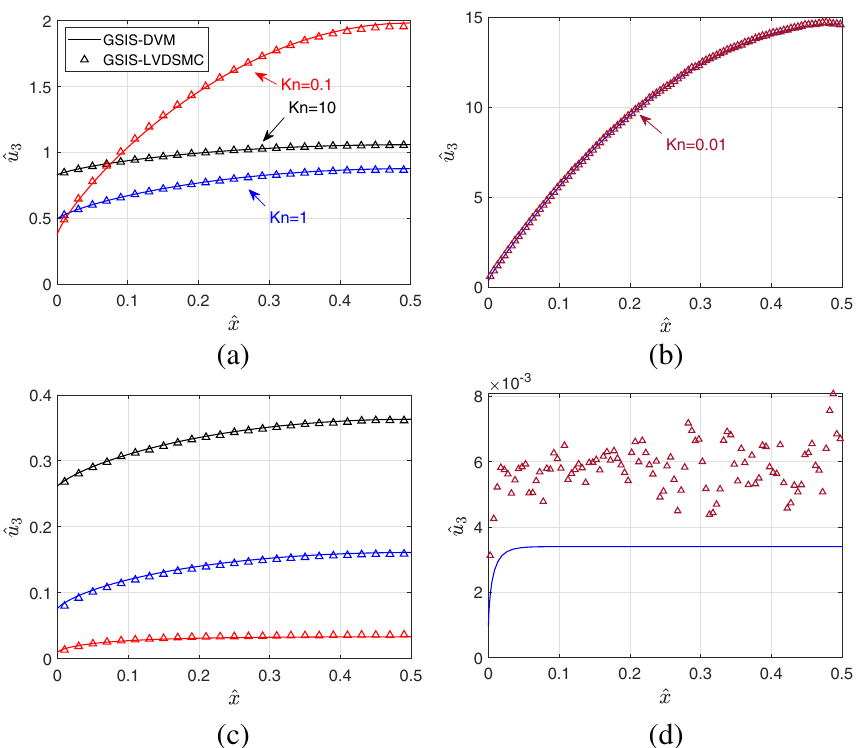
Fig. 4 Velocity profiles in the 1D Poiseuille flow (top) and thermal transpiration (bottom) when Kn = 0.01,0.1,1,10